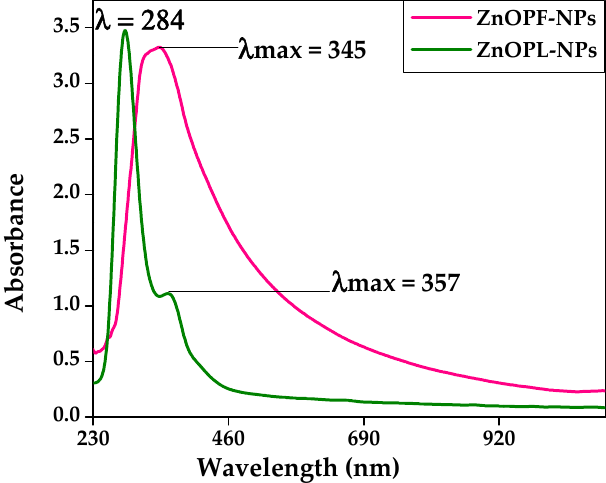
Figure 5. UV–visible spectra of zinc oxide nanoparticles synthesized from pomegranate leaf (ZnO-NPs-PL) and pomegranate flower (ZnO-NPs-PF) extracts.